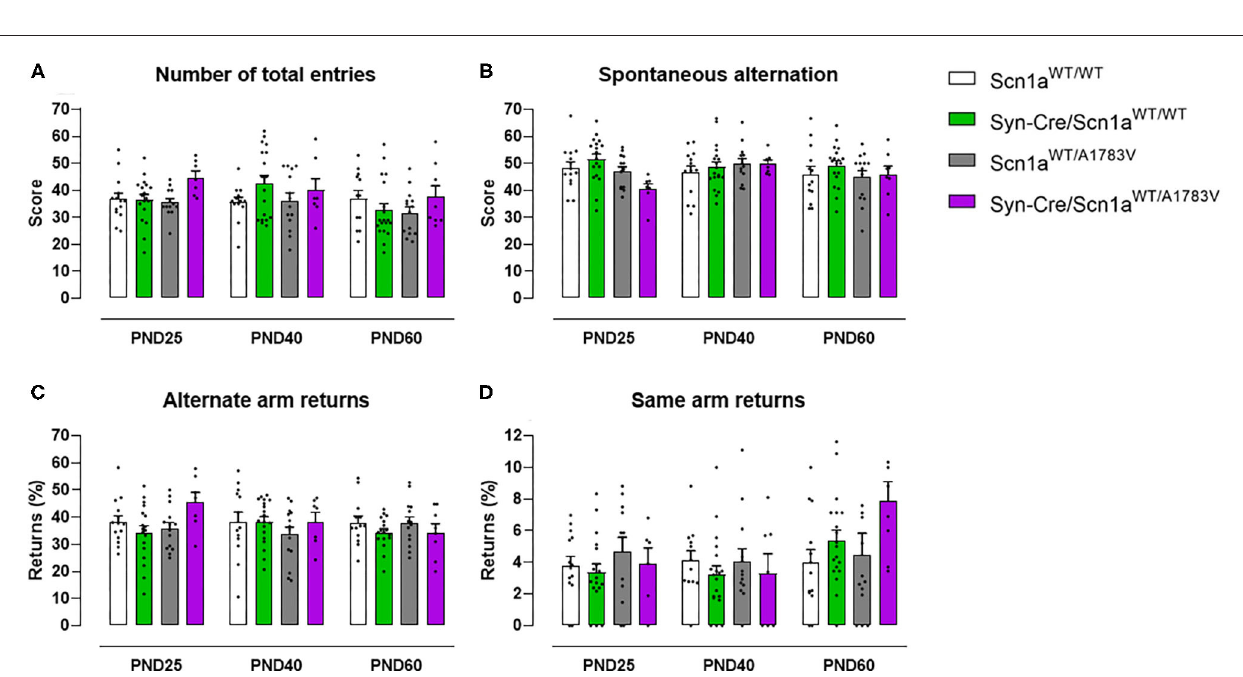
FIGURE 3 | Evolution of different behavioral parameters recorded in the Y-maze in Syn-Cre/Scn1a WT / A1783V mice and their three control groups (Scn1a WT / WT , Syn-Cre/Scn1a WT / WT , and Scn1a WT / A1783V mice) measured at different postnatal days in the range PND25–PND60. Values are means ± SEM of 13–21 animals per group. Data were assessed by using two-way ANOVA for repeated measures followed by the Bonferroni test.